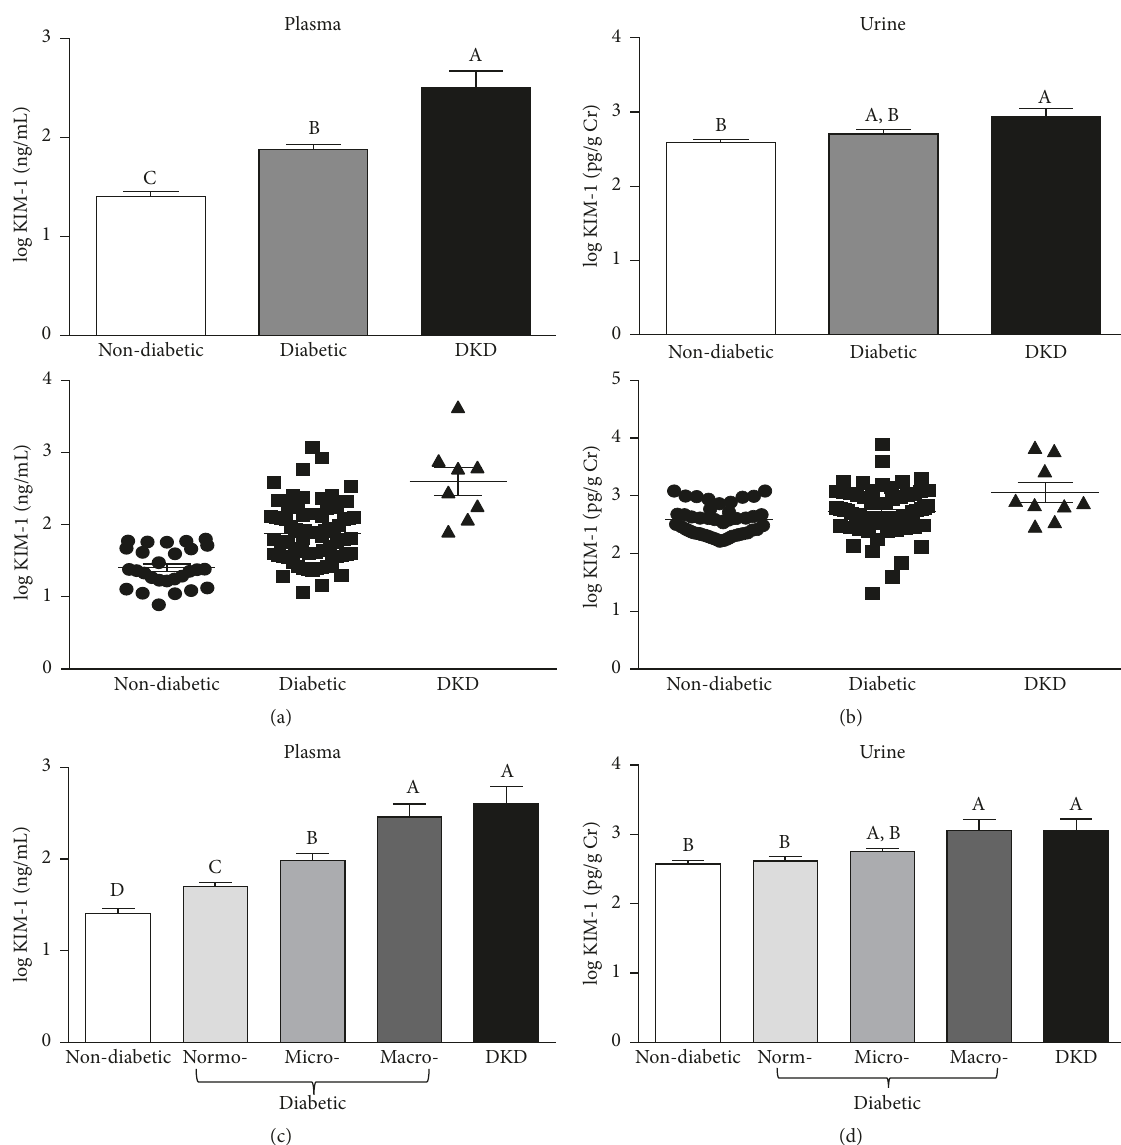
Figure 4: Plasma and urinary kidney injury molecule-1 (KIM-1). (a)-(b) Log-transformed plasma (a) and urinary (b) KIM-1 levels among nondiabetic subjects, diabetic patients with no known kidney disease (diabetic), and patients with diagnosed diabetic kidney disease (DKD). Urinary KIM-1 levels were normalized to creatinine to account for differences in urine concentration. Data are represented as both a bar chart showing mean log KIM-1 ± SEM within each group (top) and a scatter plot showing values for each individual within the group (bottom). (c)-(d) Log-transformed plasma (c) and urinary (d) KIM-1 levels among nondiabetic subjects, diabetic patients with normo-, micro, or macroalbuminuria, and patients with diagnosed diabetic kidney disease (DKD). Urinary KIM-1 was normalized to urinary creatinine. Data are represented as mean ± SEM. Labeled means without a common letter are significantly different from one another (𝑝 < 0.05) based on one-way ANOVA and Tukey’s honest significant difference